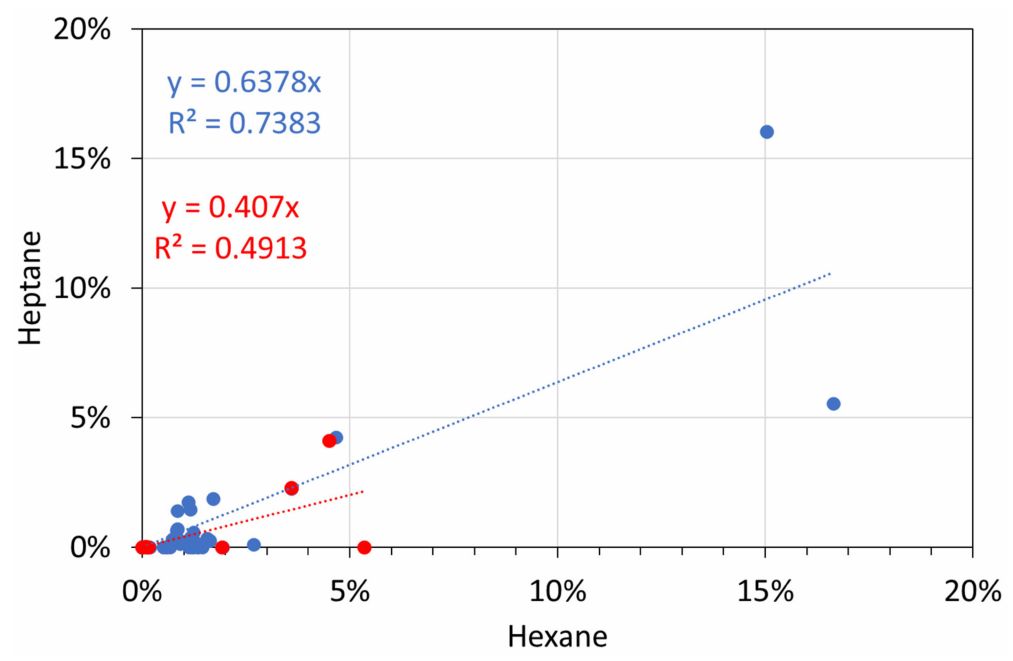
Figure A11. Molar alkane gas analyses: hexane vs. heptane. Blue circles: T ≤ 298 K; red circles: T = 348 K.